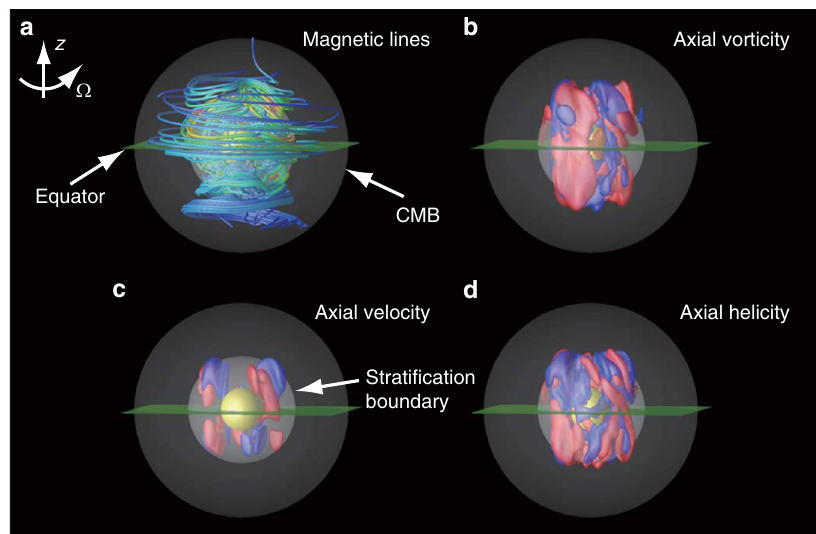
Fig. 3 Snapshot of the internal structures of the magnetic fi eld and fl ow. The snapshot is taken at the same time as in Fig. 2b in the near-equatorial view. The equatorial plane is in green, while the solid inner core is represented by a yellow sphere. The direction of rotation is aligned with the z -axis. Spherical darker regions represent the thermally stably strati fi ed layer. a Magnetic fi eld structure represented by magnetic fi eld lines. Red (blue) lines represent the strong (weak) magnetic fi eld. b The axial vorticity represented by isosurfaces of ±0.03 yr − 1 . Red denotes anti-cyclone, and blue denotes cyclone. c The axial fl ow represented by isosurfaces of ±3 kmyr − 1 . Red (blue) denotes northward (southward) fl ow. d The axial helicity distribution represented by isosurfaces of ±2300 km yr − 2 . Red (blue) denotes a positive (negative)